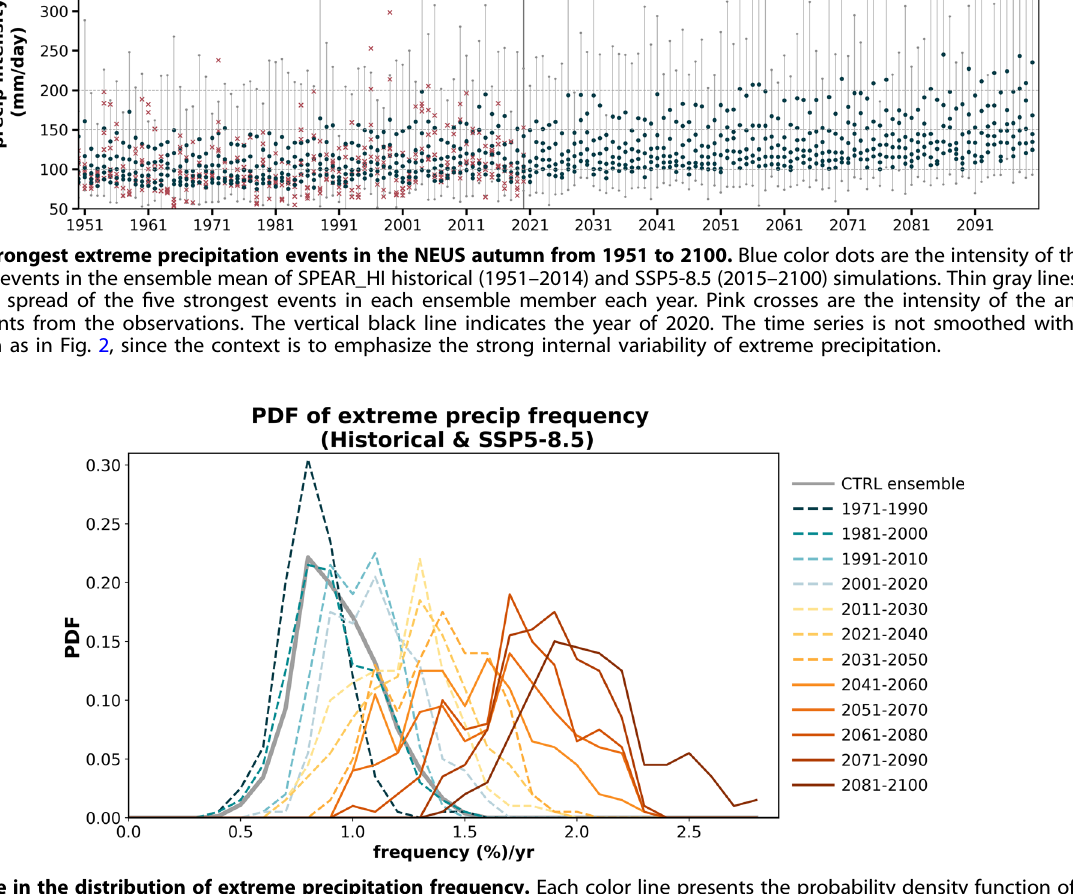
Fig. 5 Change in the distribution of extreme precipitation frequency. Each color line presents the probability density function of extreme precipitation frequency each year in a 20-year period from the SPEAR_HI historical (cold colors) and SSP5-8.5 (warm colors) simulations. The thick gray line is the PDF of extreme precipitation frequency from the preindustrial control simulations. Solid (dashed) lines indicate the medians of the distributions from the historical or SSP5-8.5 simulations are (not) statistically signi fi cantly different from the median of the distribution based on the control simulations at 95% con fi dence interval. See “ Methods ” for the